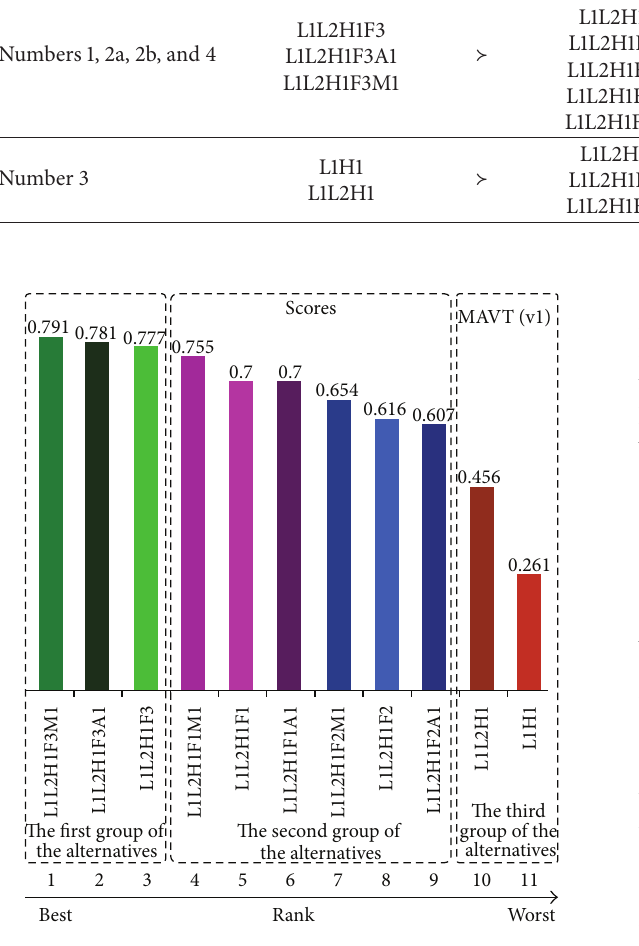
Figure 3: Ranking results for the MAVT method with weight variant number